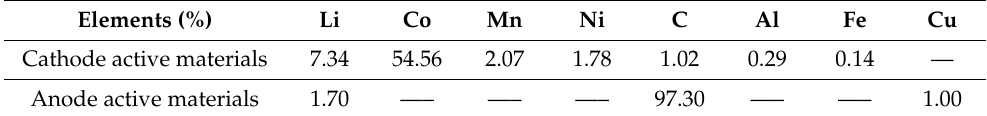
Table 1. Atomic percentage of the electrode active materials composition.